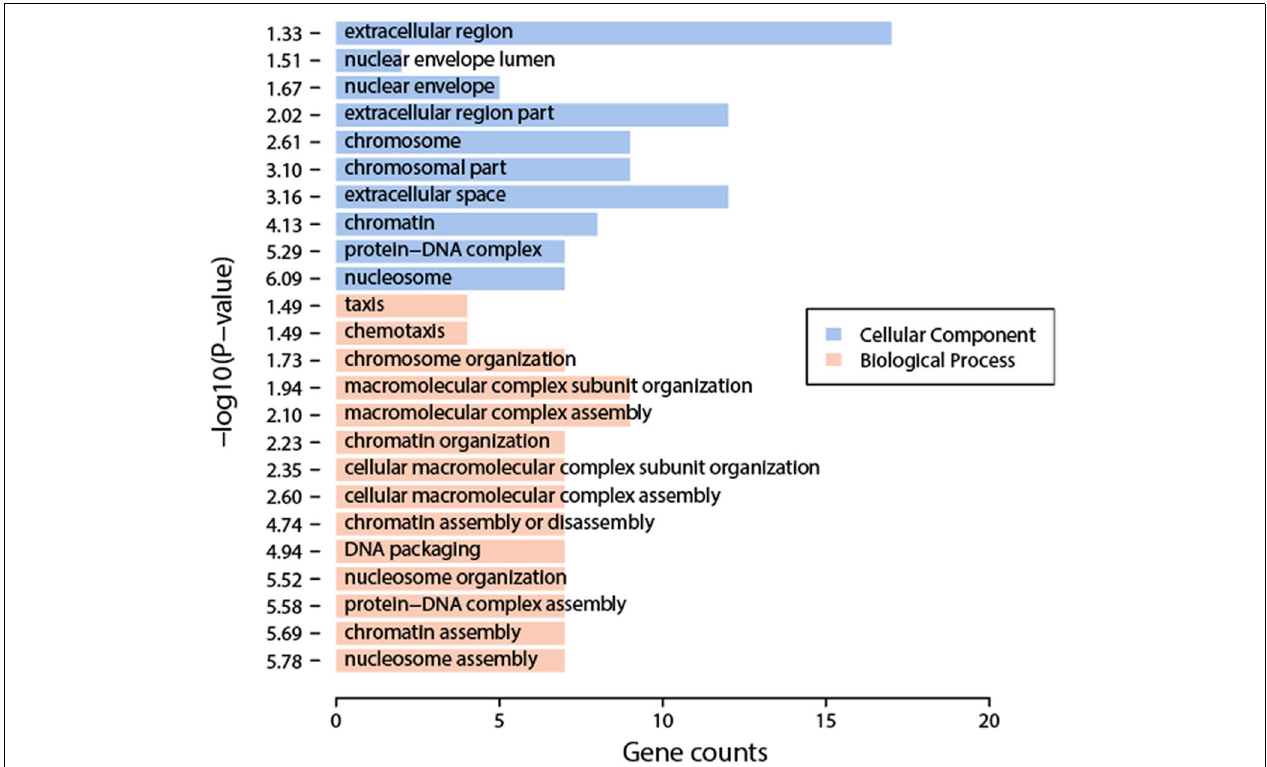
FIGURE 2 | Enriched GO terms of differentially expressed genes between BDE-209 and DMSO samples. Biological process GO terms (pink bars) are mainly related to chromatin remodeling such as nucleosome